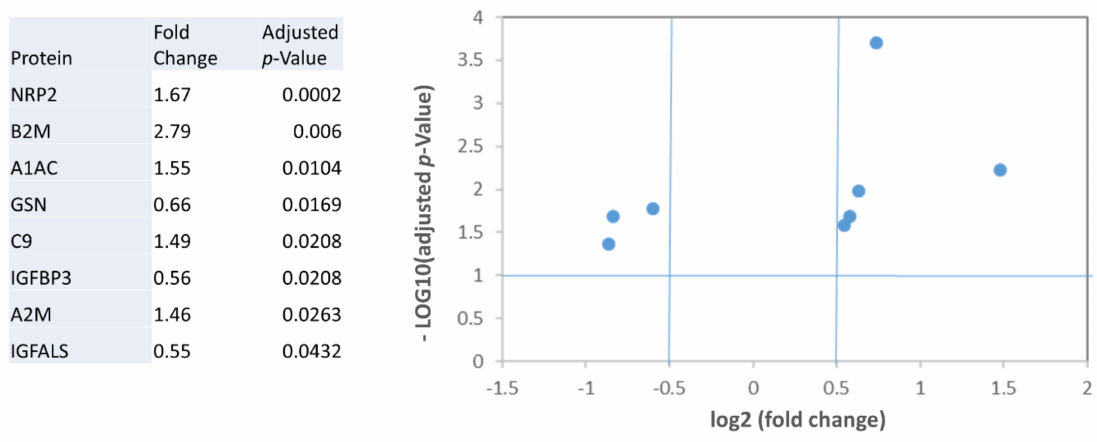
Figure 2. Differentially expressed proteins in patients with severe HF (VO 2 /Kg < 12 mL/min/Kg) in relation to control subjects. Table and graphical representation in a Vulcano plot of the fold changes, and statistical significance for the proteins with different levels after adjustment for multiple testing.